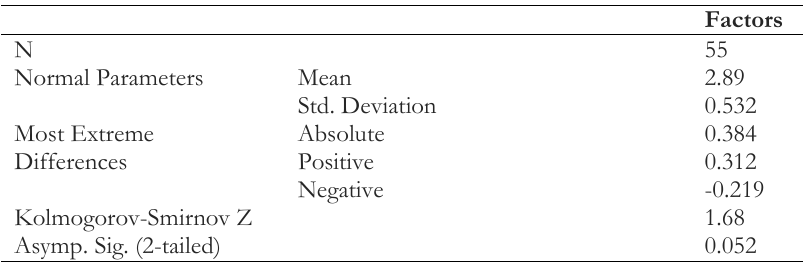
Table 2. The software output for